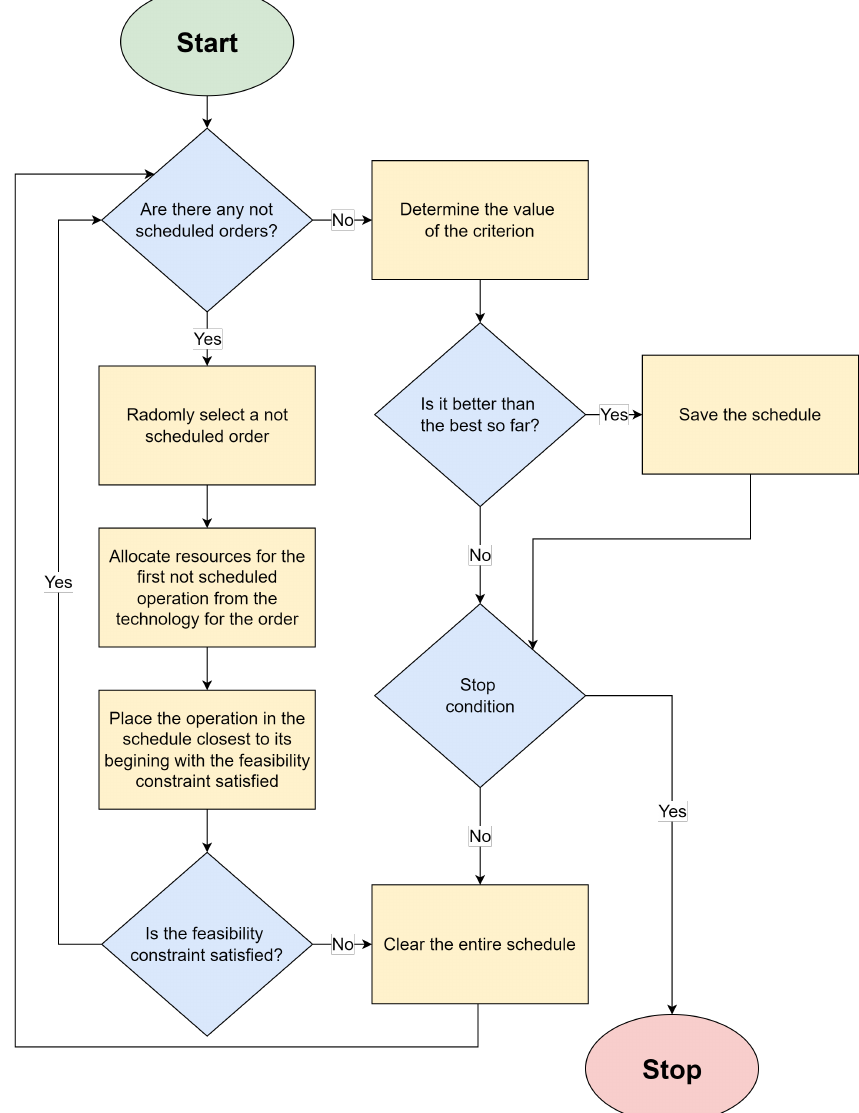
Figure 3. Flowchart of the lab optimization